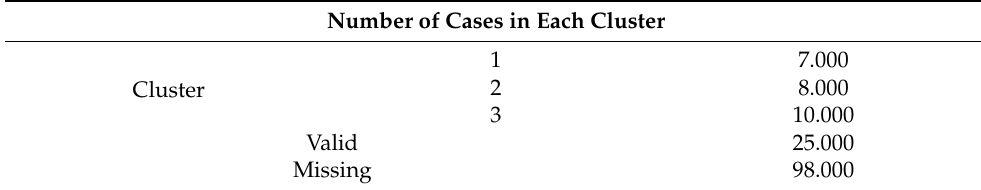
Table 6. Number of observations in each cluster, compiled by the